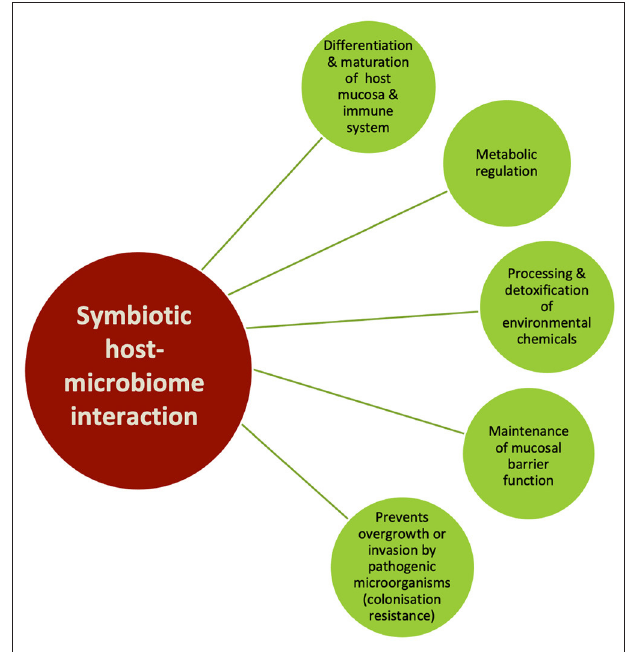
FIGURE 3 | Functions of a symbiotic host-microbiome